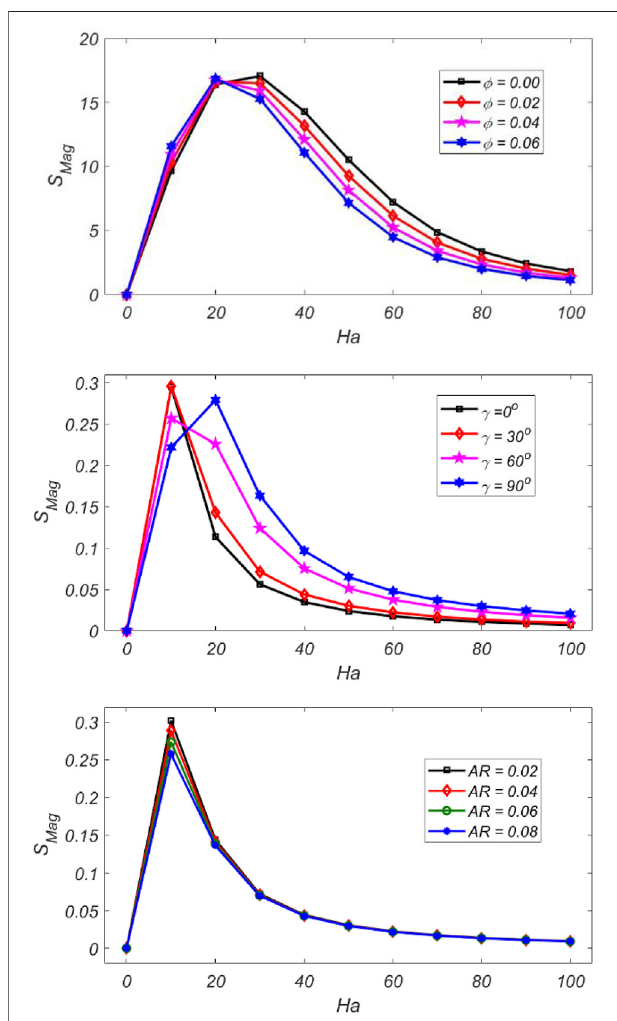
FIGURE 6 | Impacts on S Mag against Ha for different